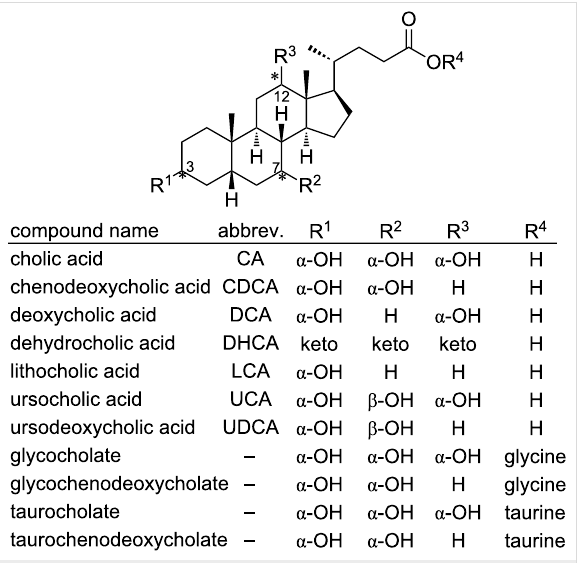
Figure 2: Chemical structures of bile acids and